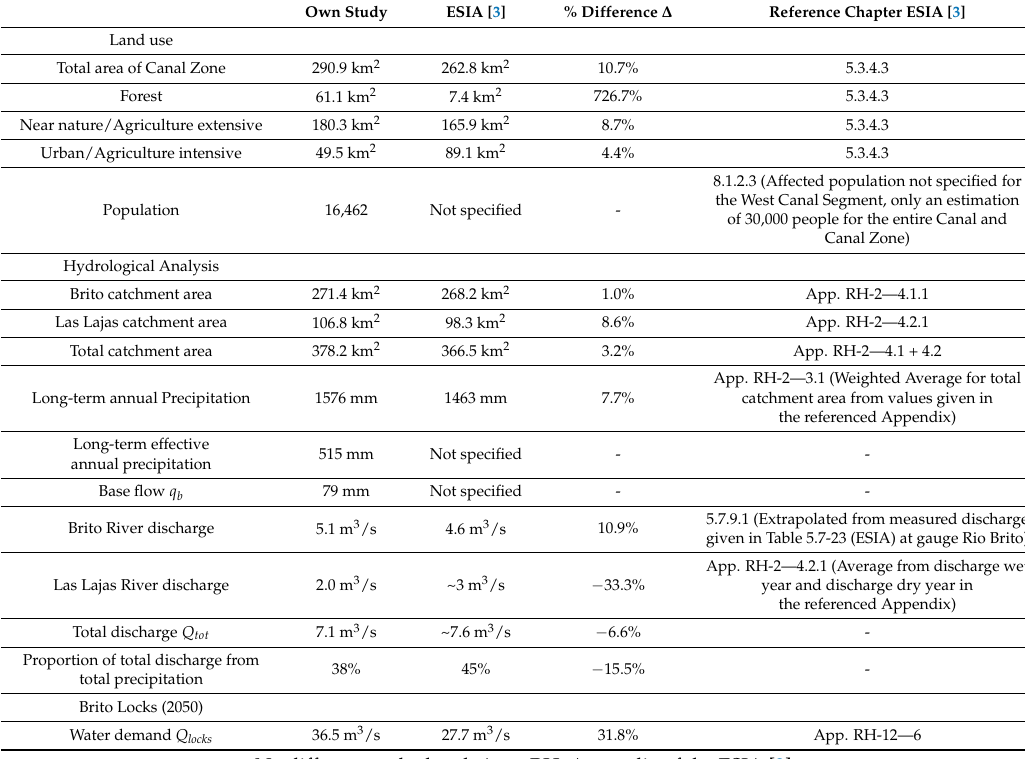
Table 1. Analysis of results in comparison with published results from the Environmental and Social Impact Assessment